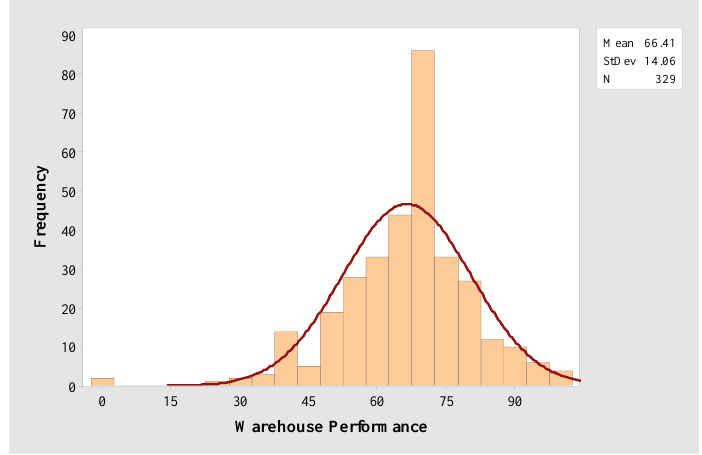
Figure 10: Histogram of the distribution of the level of sensitivity for warehouse performance